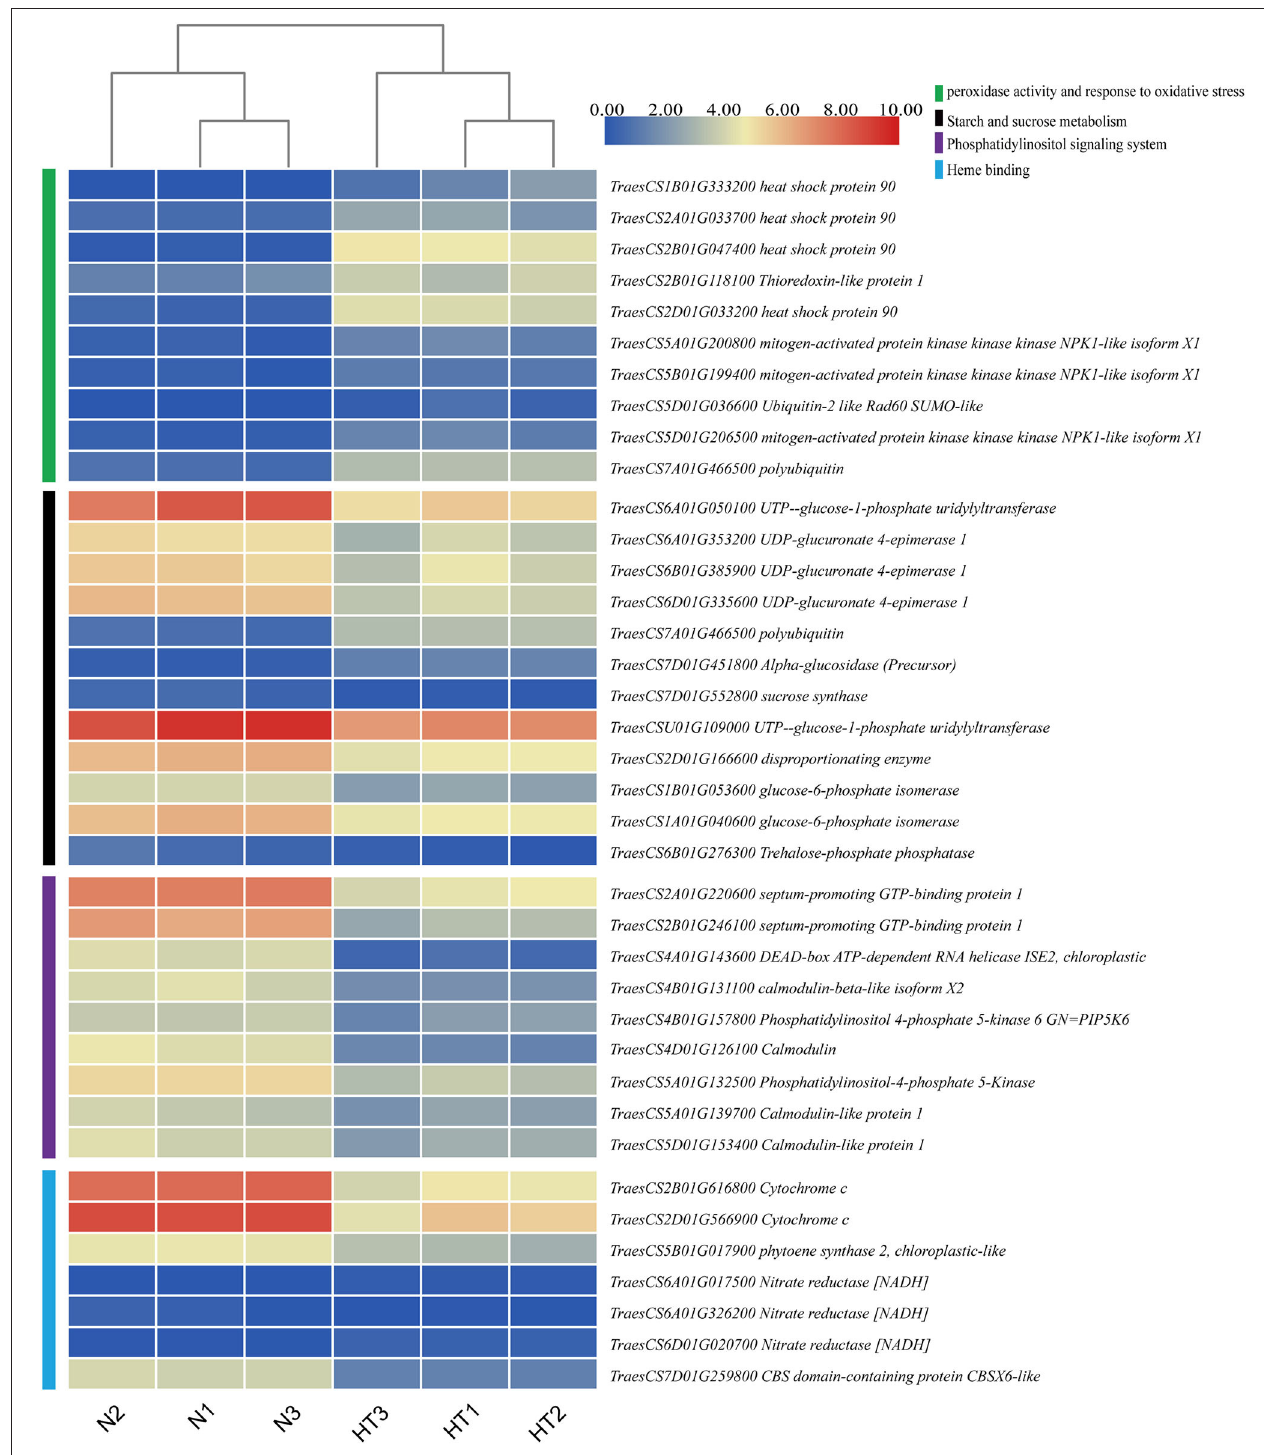
FIGURE 9 | Hierarchical clustering analysis of hub DEGs in the crucial pathway. The green, black, purple, and cyan vertical boxes represent the peroxidase activity and response to oxidative stress pathway, starch and sucrose metabolism pathway, phosphatidylinositol (PI) signaling system, and heme binding, respectively. The gradient color of the legend represents the log2 (FPKM)